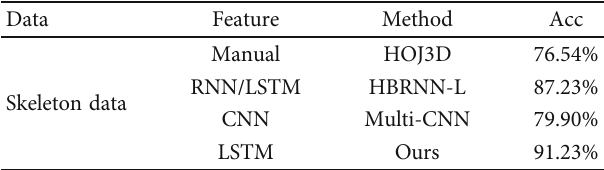
Table 1: Experimental results on the